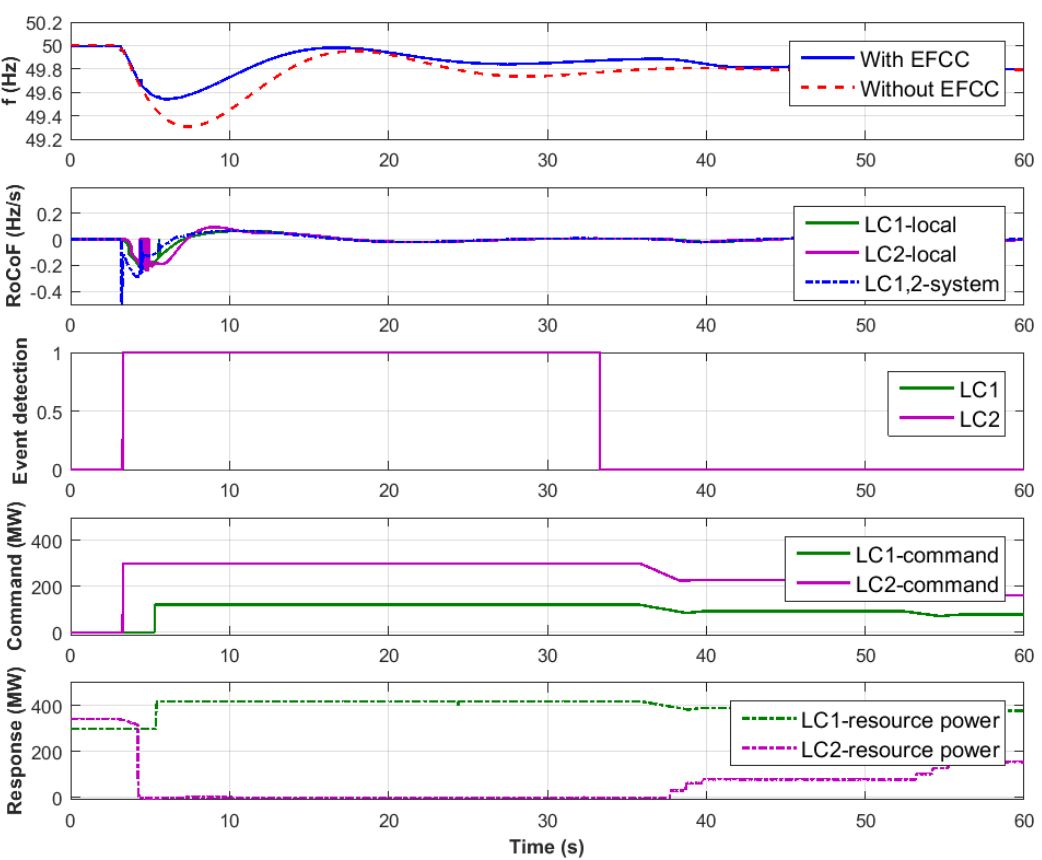
Figure 7. Measurements made during a verification experiment